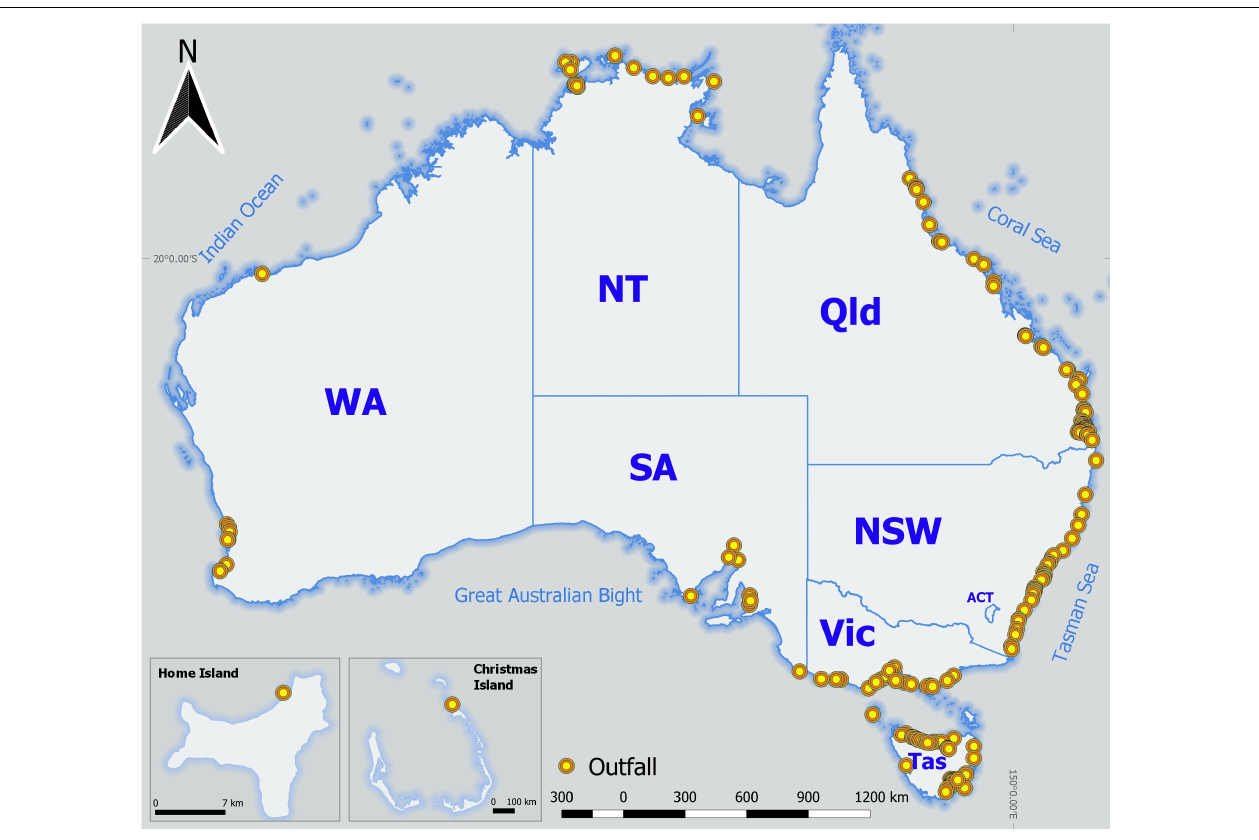
FIGURE 1 | Australian coastal outfalls recorded in the